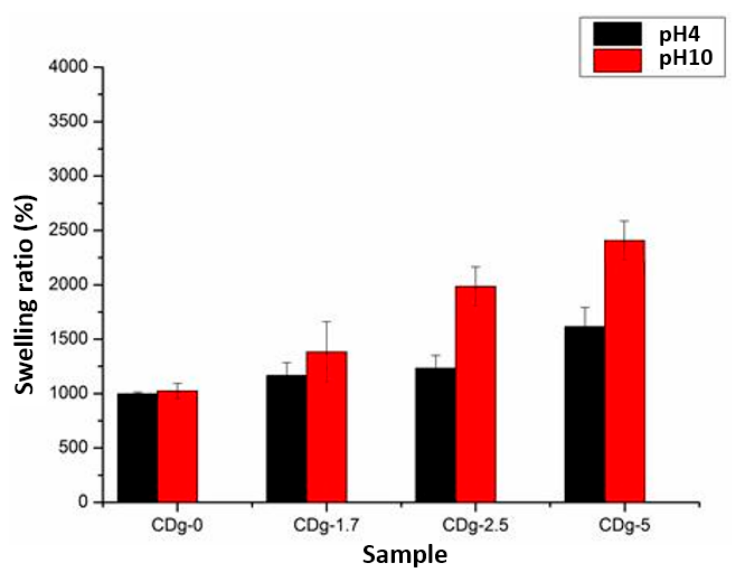
Figure 11. Swelling ratios of hydrogels in buffer solution (pH = 4 and 10).